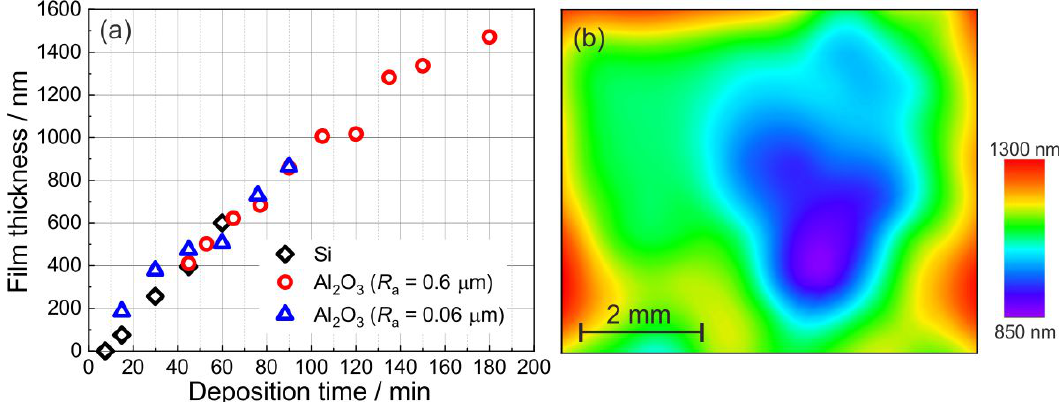
Figure 3. ( a ) Mean thickness of the electroless-deposited Pt-based film on a 100 nm Pt seed layer at an electrolyte temperature of 70 ◦ C in the presence of the additive I (0.1 g/L) and the additive II (0.5 g/L) and ( b ) film thickness distribution of an exemplary sample obtained from XRF measurements (deposition time 120 min, average thickness 1000